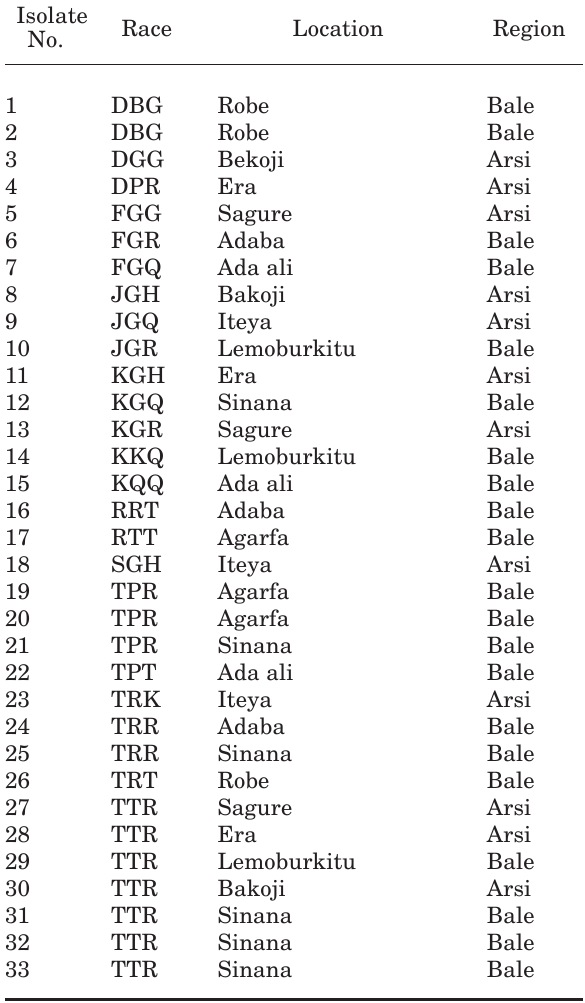
Table 2. Races of Puccinia graminis f. sp. tritici in the Arsi and Bale regions of Ethiopia in 2002. Isolate